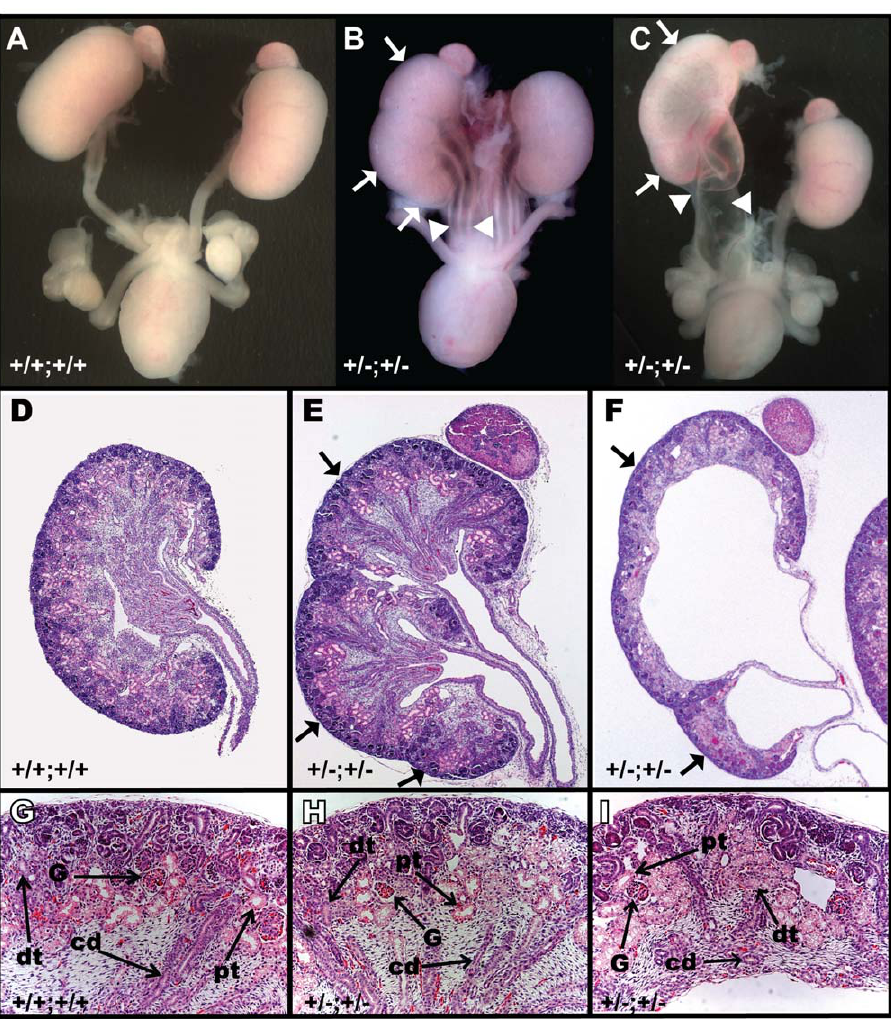
Figure 1. Pax2;Emx2 compound heterozygotes display gross UGS morphological defects. (A,B,C) Isolated E18.5 urogenital systems of the indicated genotypes. (D,E,F) Hematoxylin/eosin staining of cross sections of kidneys in A, B and C, respectively. (G,H,I) Higher magnification of kidneys shown in D, E and F. Defects observed are triplex kidneys with duplex and bifid ureters (white arrows and arrowheads in B and E), and duplex kidney associated with hydronephrosis and megaureter (arrows and arrowheads in C,F). Histological analysis in G,H,I reveals normal tissue differentiation in compound heterozygotes (H,I) compared to wild-type (G). pt: proximal tubule; dt: distal tubule; G glomerulus; cd: collecting duct.